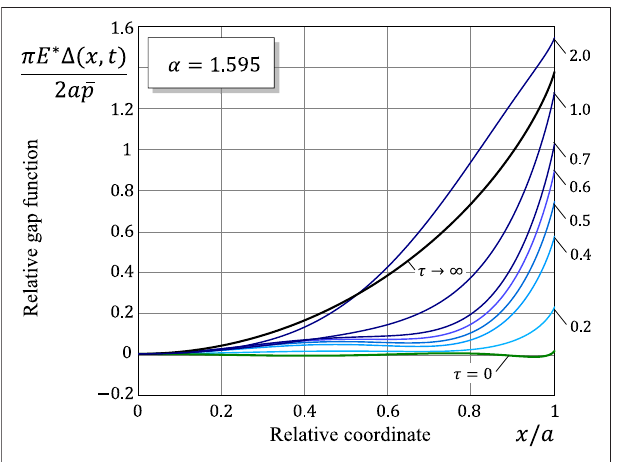
FIGURE9| Space-variationofthegapfunctionfordifferentvaluesofthe relative time variable τ = t / τ in in the sub-Archard wear case.